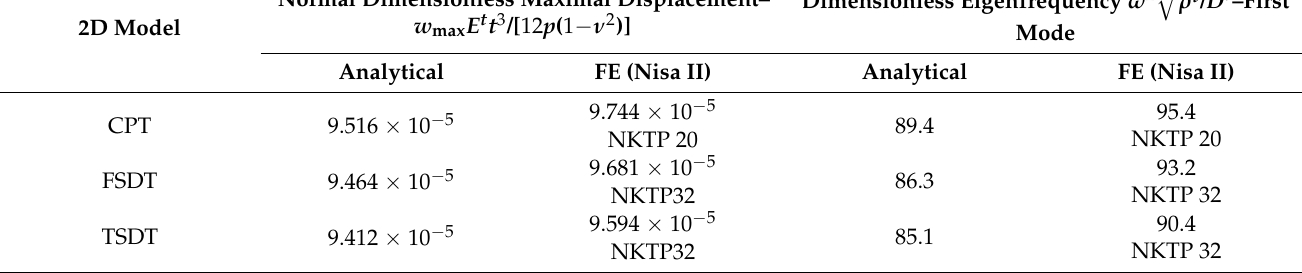
Figure 6. Modes of natural frequencies for different boundary conditions.